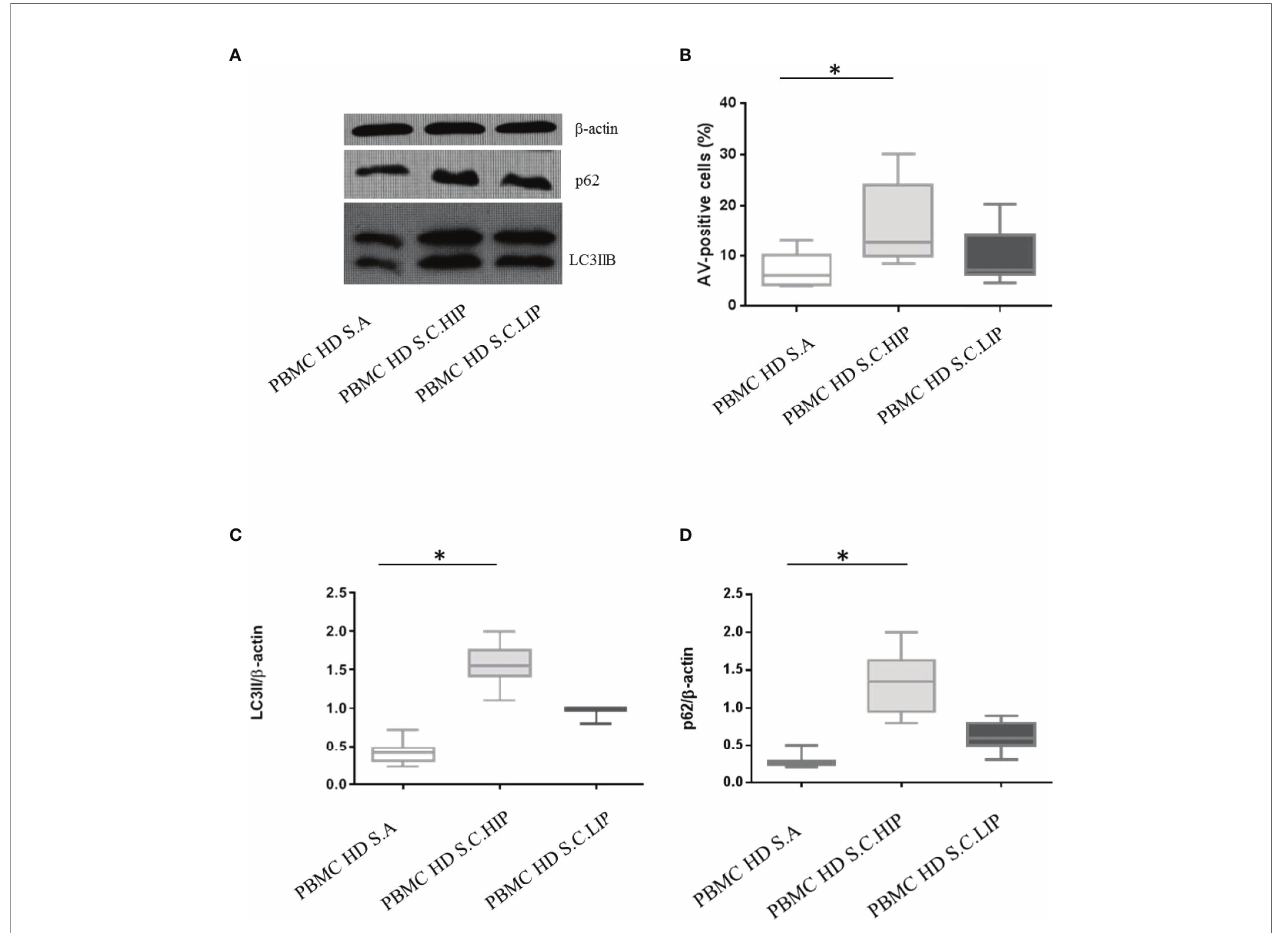
FIGURE 5 | Effects of sera from patients with COVID-19 on HD PBMC autophagy and apoptosis. (A) LC3IIB and p62 Western blotting analysis of PBMC lysate (30 m g/lane) from 1 representative HDs in vitro treated with autologous sera (S.A), with sera from 1 HIP COVID-19 patients (S.C.HIP) and from 1 COVID-19 classi fi ed as LIP (S.C.LIP) (B) Flow cytometry analysis of PBMC apoptosis. Data are referred to as AV-positive cells and are presented as 10 independent experiments performed on HDs in vitro treated with sera from HIP COVID-19 patients and COVID-19 classi fi ed as LIP (Student ’ s t-test). Densitometry analysis of LC3IIB (C) and p62 (D) levels relative to b -actin is also shown (10 independent experiments) (Mann – Whitney test). Values are expressed as means ± SD. * p < 0.05. PBMC, peripheral blood mononuclear cell; HD, healthy donor; COVID-19, coronavirus disease 2019; HIP, high in fl ammatory pro fi le; LIP, low in fl ammatory pro fi